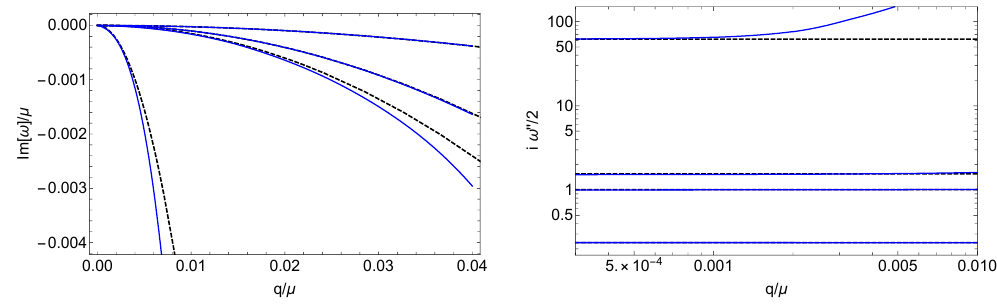
Figure 2 . In the left panel we show the dispersion relations for the four diffusive modes in our system. The dashed lines represent the dispersion relations obtained from the linear system in (3.57). In the right panel we plot iω ( q ) 00 / 2 as a function of q for each one of the four diffusive modes that we have found numerically. In the limit of small momenta the value of this function converges to the diffusion constants we find from equation (3.57), shown here with dashed lines. In this figure we used ( φ s , ψ s , T, µ, k, k s , γ, δ, B ) =